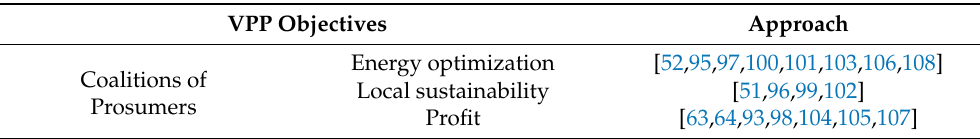
Table 5 summarizes the general objectives of the studied VPP communities’ approaches. Table 5. VPP objective for energy